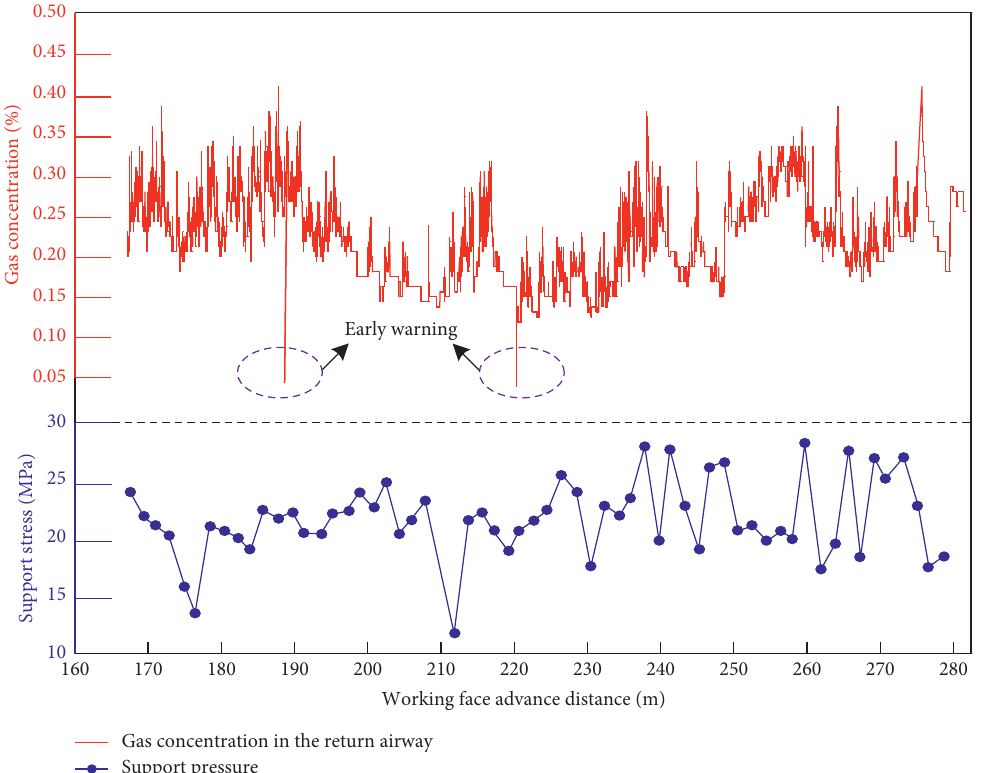
Figure 8: Early warning of support pressure and average gas concentration change curve after pressure